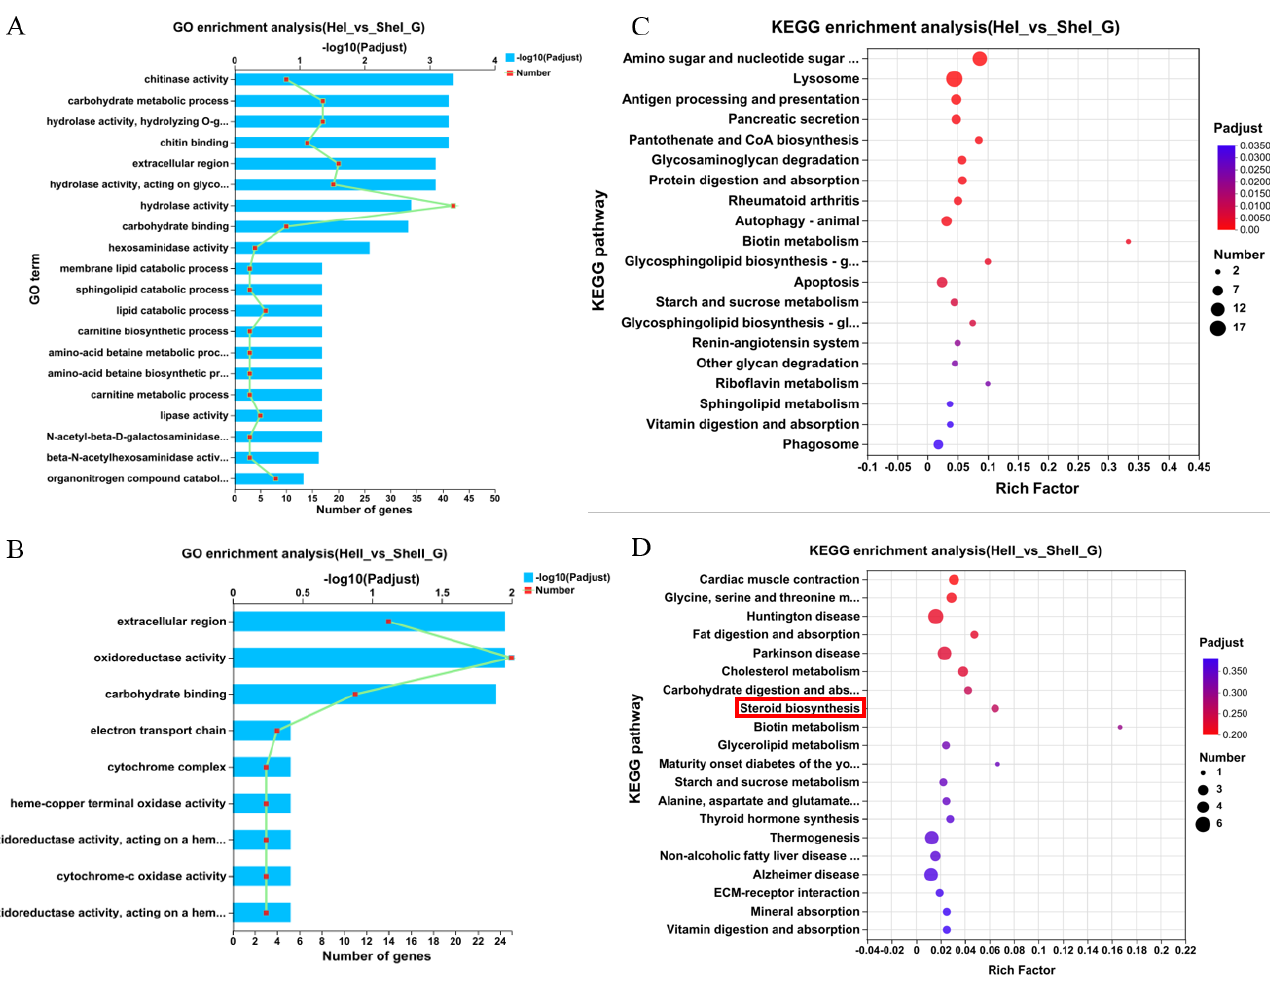
Figure 4. GO and KEGG pathway enrichment analyses of non-redundant transcripts in the hepato- pancreas after unilateral eyestalk ablation in E. carinicauda . ( A ) Top 20 enriched biological processes in HeI_vs_SHeI and ( B ) HeII_vs_SHeII . ( C ) Top 20 significant enriched KEGG pathways in HeI_vs_SHeI and ( D ) HeII_vs_SHeII .